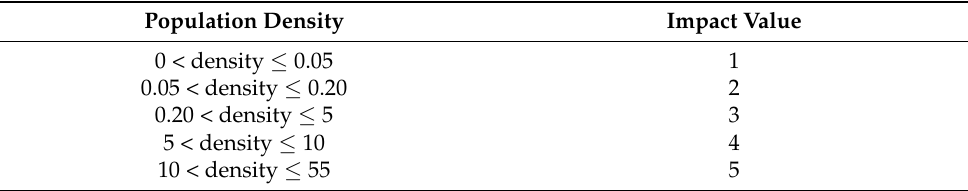
Table 12. Reclassification of the population